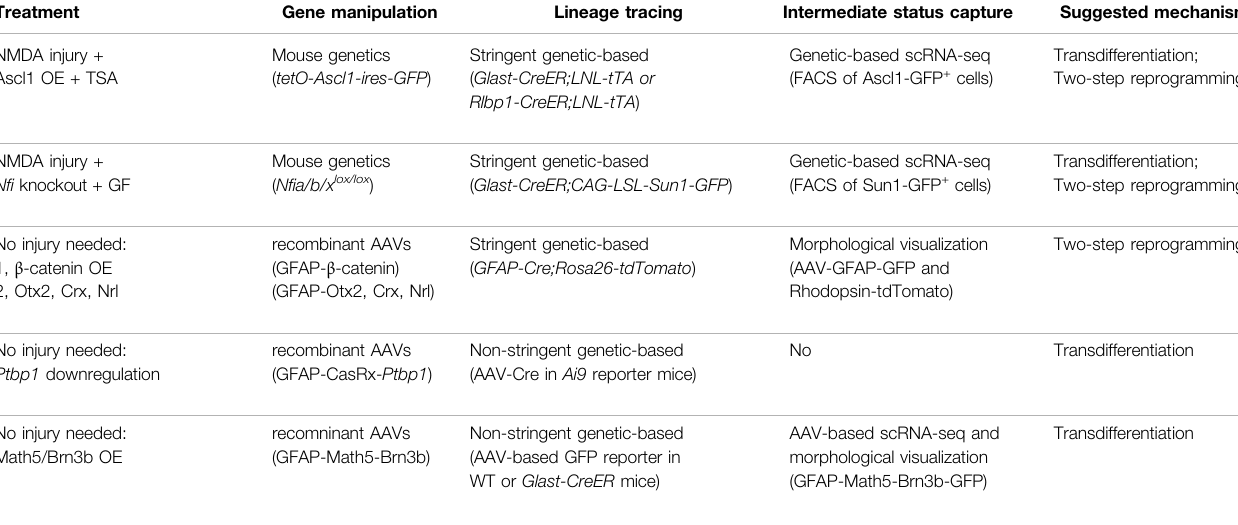
TABLE 1 | Summary of methods and criteria used to evaluate the MG-derived neurogenesis in adult mouse retina.